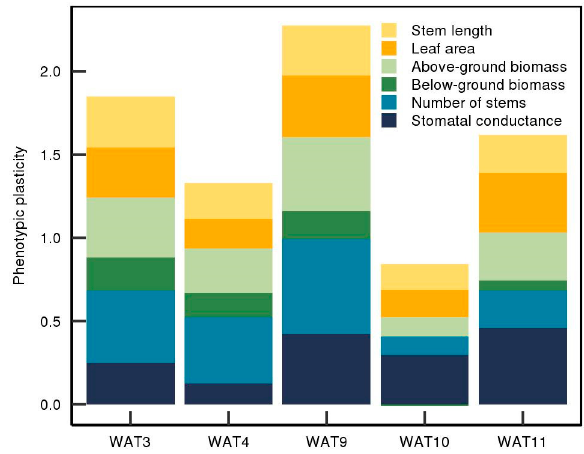
Figure 5. Index of phenotypic plasticity for six phenotypic traits for five genotypes: the length of the main stem, youngest fully expanded leaf area, above-ground biomass, and below-ground dry biomass at the end of the experiment, number of stems, and stomatal conductance.